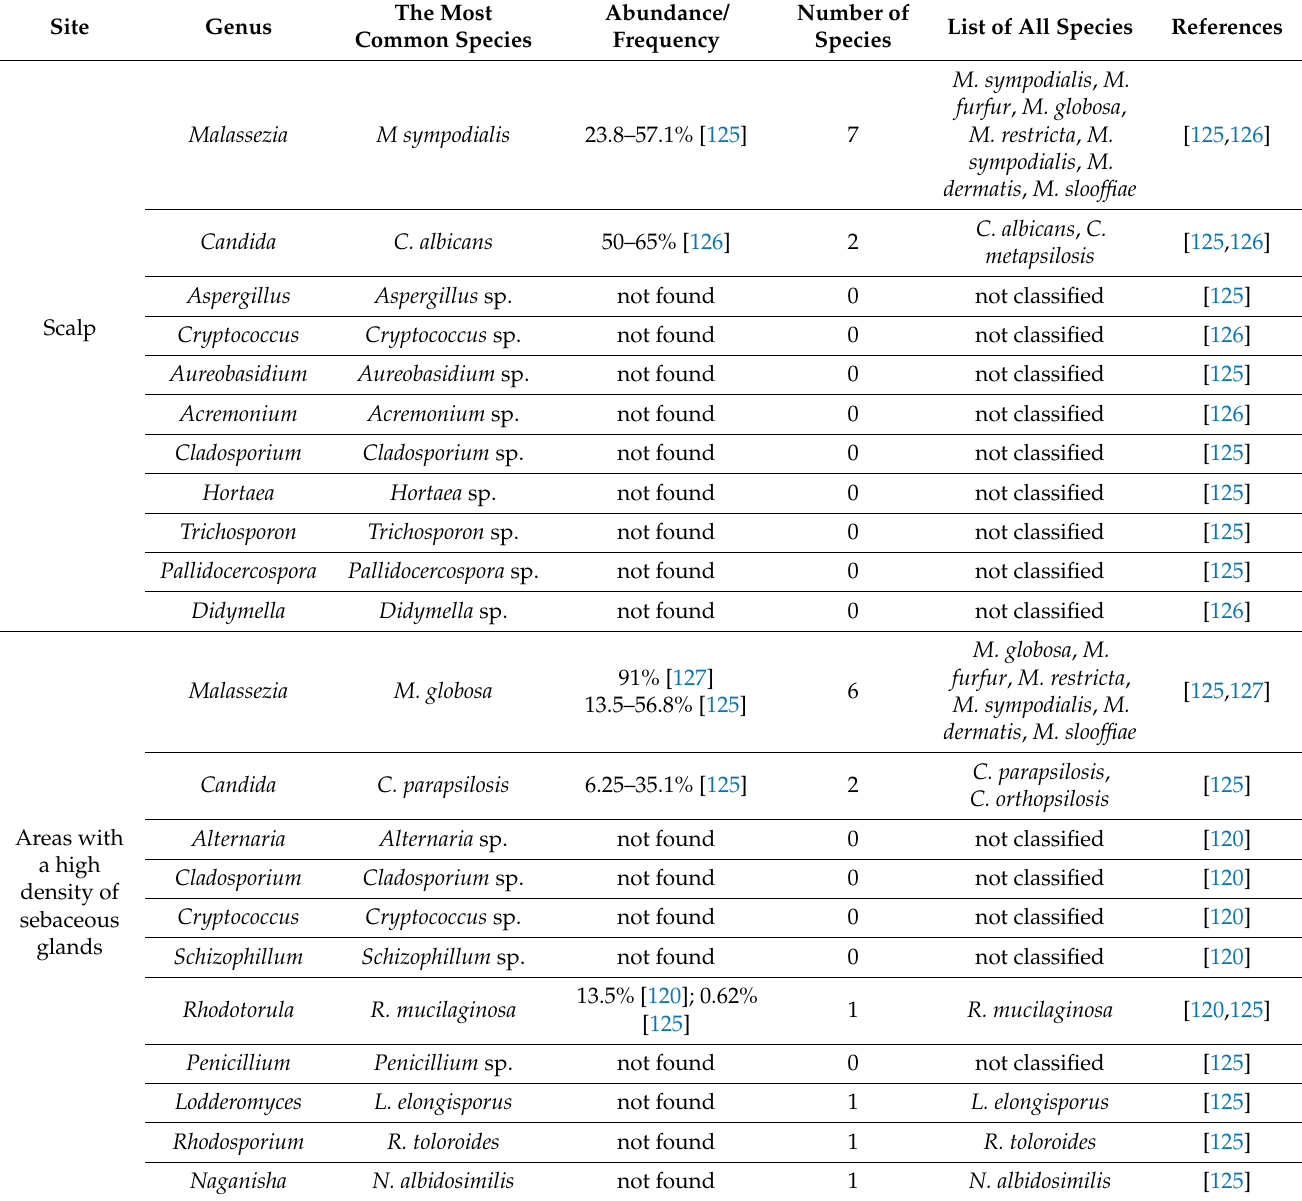
Table 6. The list of chosen skin mycobiome colonizers. The table summarizes the relative abundance (or frequency) of representative taxa, number and summary of all species described in the